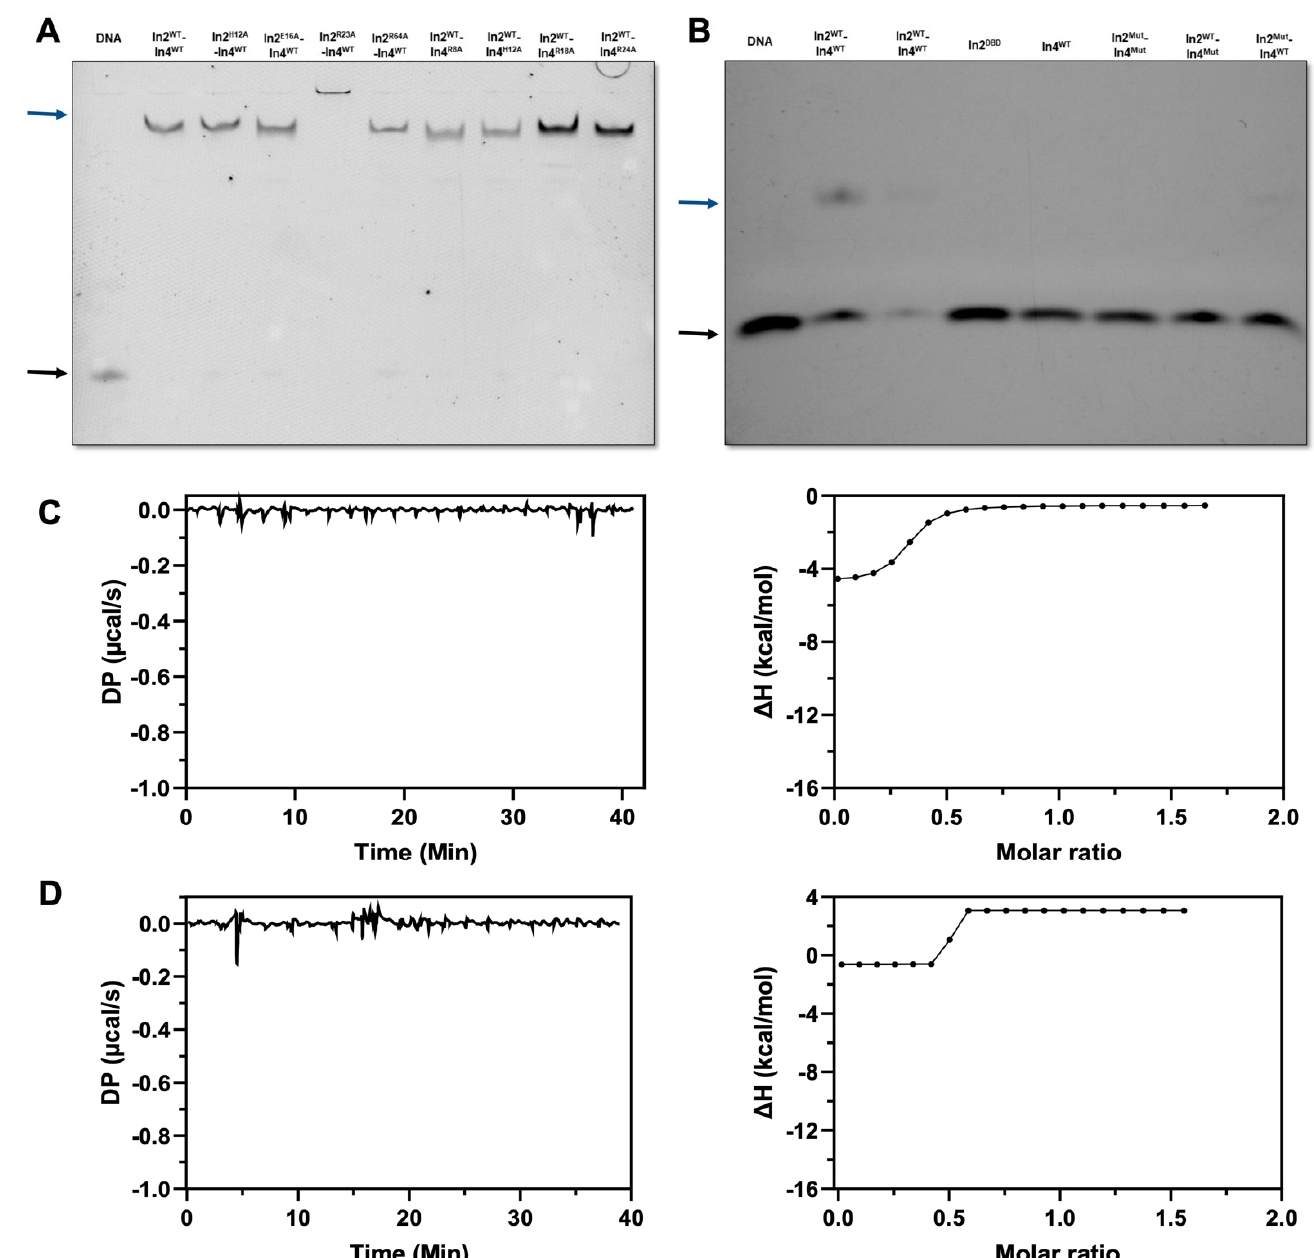
Figure 4. Binding profiles of Ino2p DBD /Ino4p DBD and the promoter DNA fragment: ( A ) Interaction of single-residue mutations and wild-type promoter DNA binding sequence; ( B ) Interaction profiling of a multiple-residue mutation in Ino2p DBD and Ino4p DBD with the native promoter fragment. Ino2p and Ino4p are labeled as 2 and 4, respectively. Superscripts indicate individual mutants. DNA alone is indicated by a black arrow, while the Ino2p DBD /Ino4p DBD /DNA complex is designated with a blue arrow; ( C , D ) Interaction pattern of ( C ) Ino2p Mut and ( D ) Ino4p Mut with the promoter fragment via ITC. These analyses were performed in triplicate.